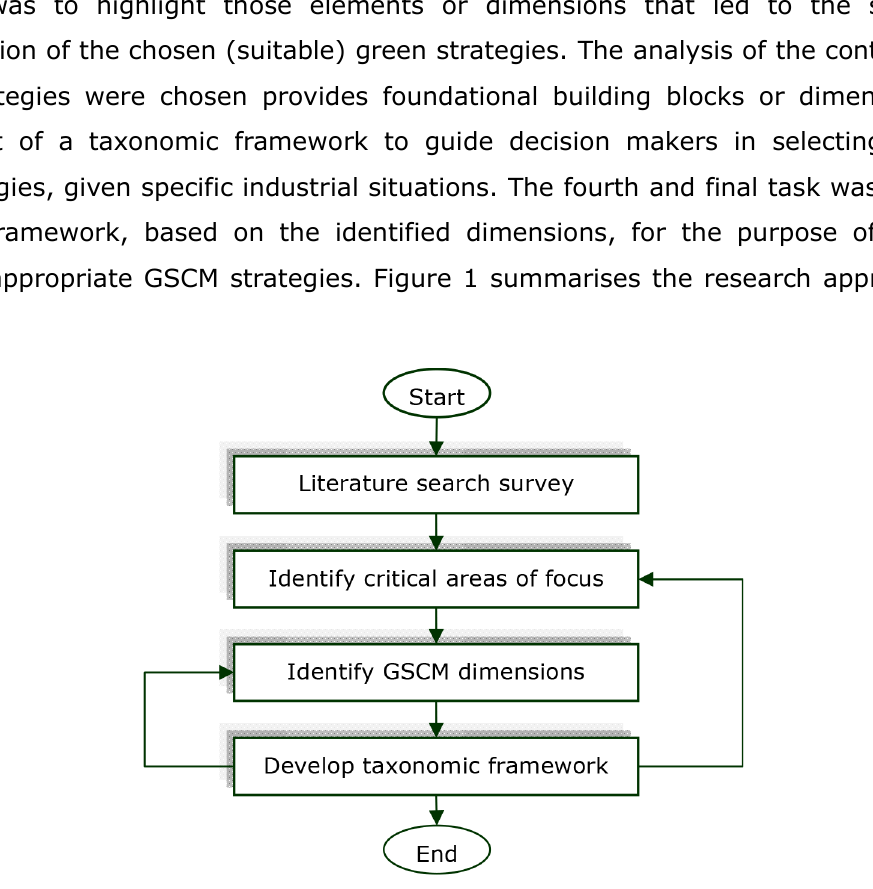
Figure 1. Research